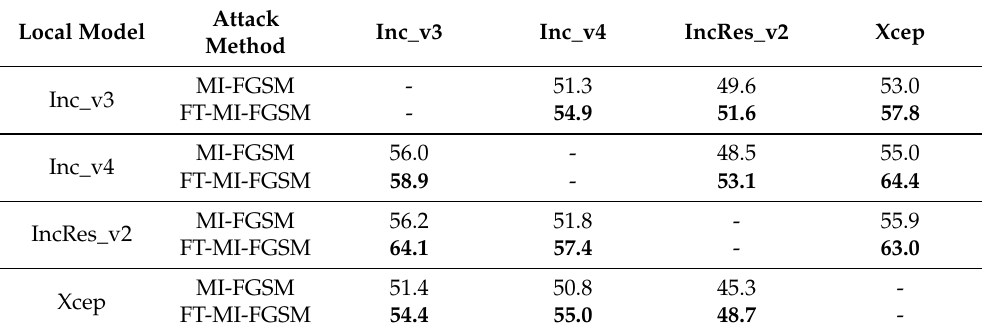
Figure 3. Adversarial examples generated by MI-FGSM, DIM, SIM, Admix, the proposed FT-MI- FGSM, FT-DIM, FT-SIM, and FT-Admix on the Inc_v3. Table 2. The black-box ASRs of MI-FGSM and FT-MI-FGSM on ImageNet. The first column is the local model, and the first row is the target model. The values in the table are the ASRs (%) on the target models using the adversarial examples generated with the local models. The higher ASRs are shown in bold.